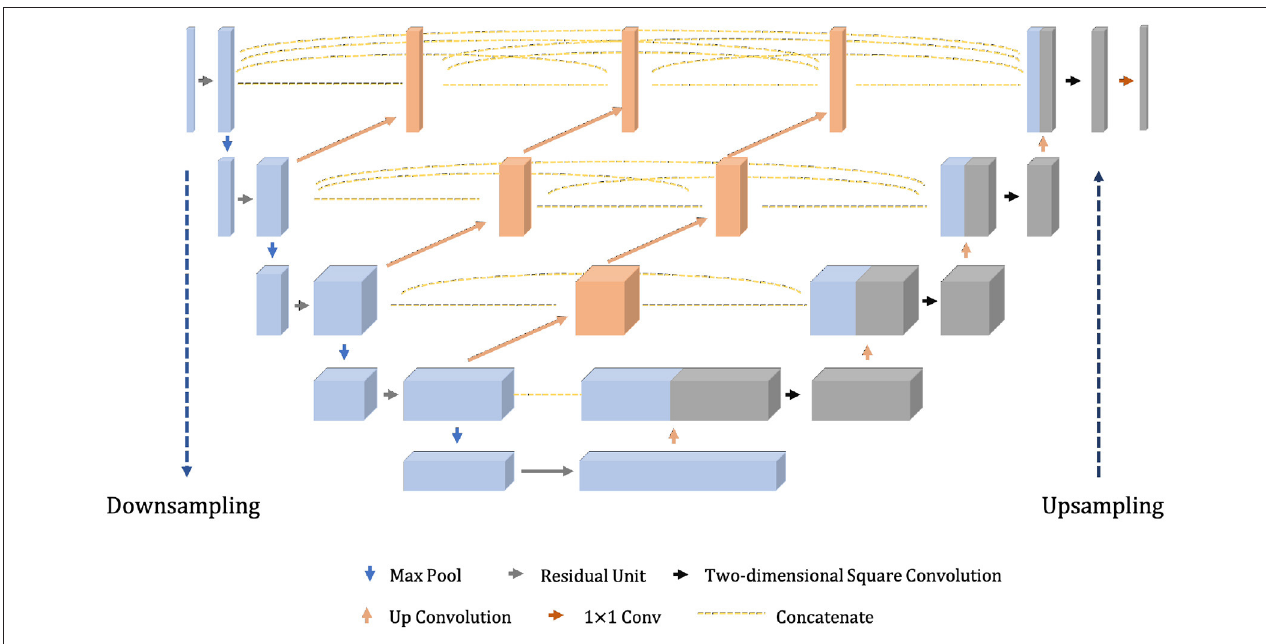
FIGURE 2 | The overall structure of our proposed Dense-ResUNet.